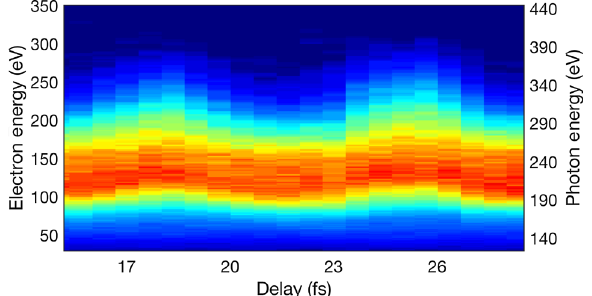
FIG. 4. Streaking trace (linear scale) from the water-window attosecond pulse recorded in Kr.